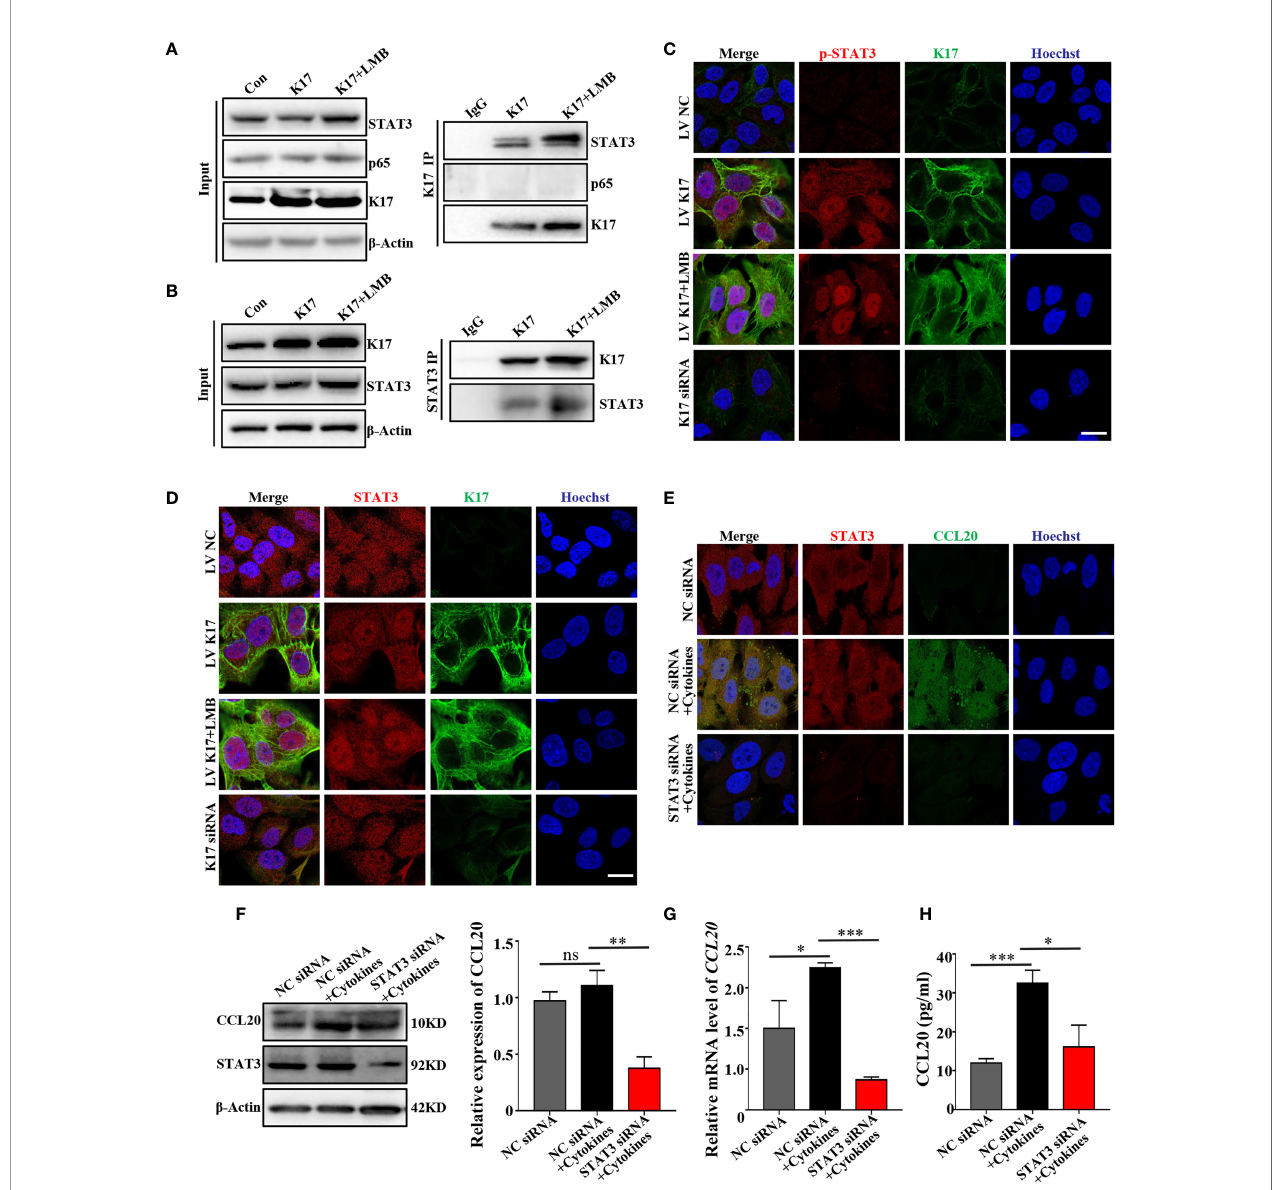
FIGURE 6 | Nuclear translocation of K17 enhances the interaction with STAT3 and promotes STAT3 activation to upregulate CCL20 expression. Cells were co- immunoprecipitated with (A) anti-K17 and (B) anti-STAT3 and detected by western blot. (C) Immuno fl uorescence staining of STAT3 (red), K17 (green) and Hoechst (blue). Scale bar, 10 m m. (D) Immuno fl uorescence staining of p-STAT3 (red), K17 (green) and Hoechst (blue). Scale bar, 10 m m. (E) Immuno fl uorescence staining of CCL20 (green), STAT3 (red) and Hoechst (blue). Scale bar, 10 m m. (F) CCL20 level was analyzed by western blot. (G) Relative CCL20 mRNA expression was analyzed by qRT-PCR. Data represent the mean ± SD ( n = 3). (H) CCL20 levels secreted into keratinocytes cell culture medium were measured by ELISA. Data represent the mean ± SD ( n = 3). * p < 0.05, ** p < 0.01, *** p < 0.001, ns, not signi fi cant. All experiments were repeated for at least three